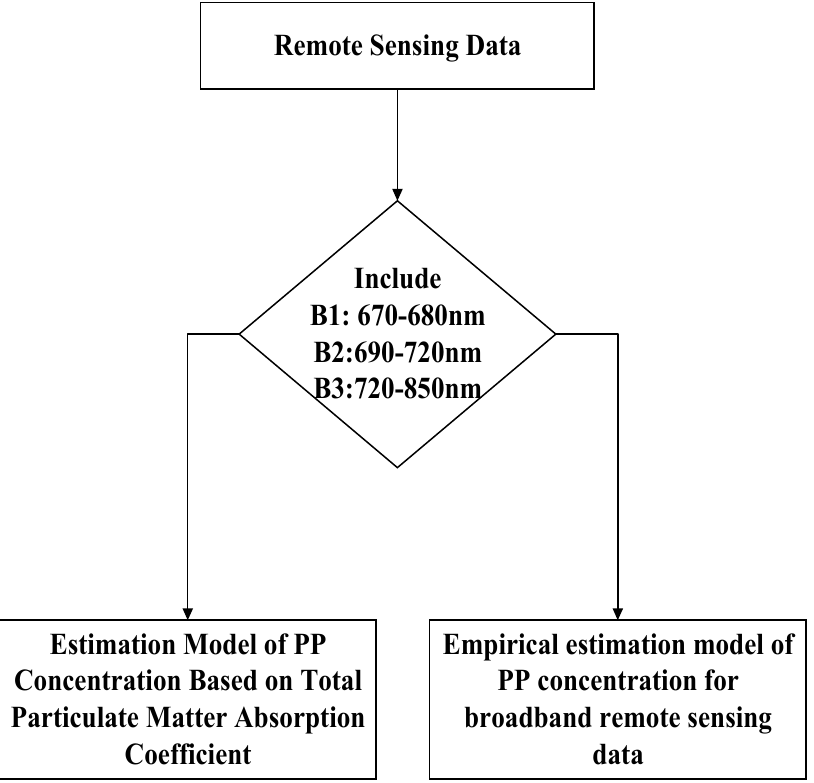
Figure 10. Flow chart of the remote sensing-based model workflow used in this study to estimate PP PP concentrations. Table 2. Selection of common sensors for estimating PP concentrations in Hongze Lake.